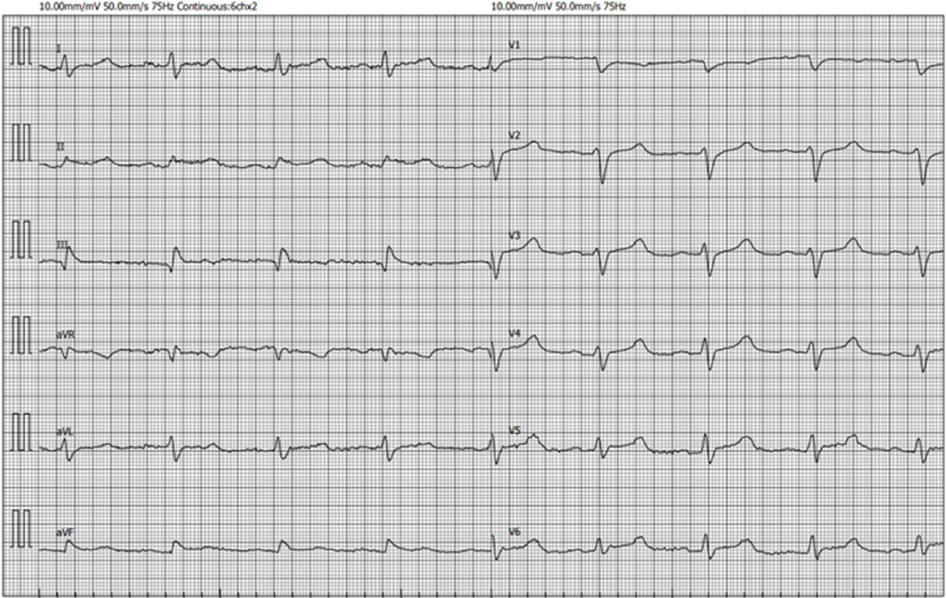
Figure 1. Admission ECG showing sinus tachycardia with slightly elevated ST segment in II, aVF leads.